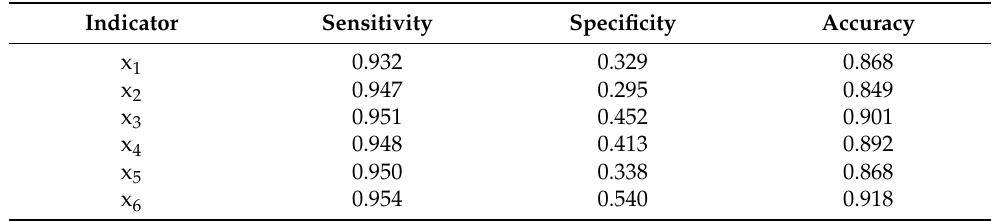
Table 6. The indices’ sensitivity, specificity, and accuracy for the 143 tests based on naïve Bayes algorithm.